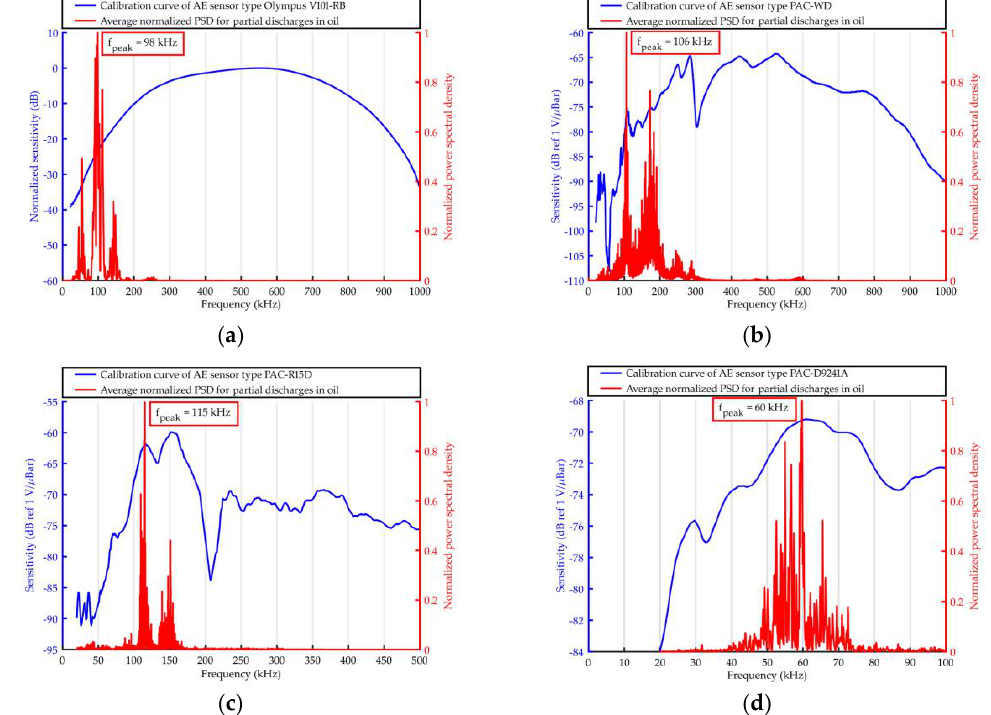
Figure 14. Average normalized PSD determined for AE signals emitted by partial discharges in oil and registered with the use of ultrasonic sensor type: ( a ) Olympus V101-RB, ( b ) PAC WD, ( c ) PAC R15D, and ( d ) PAC D9241A.